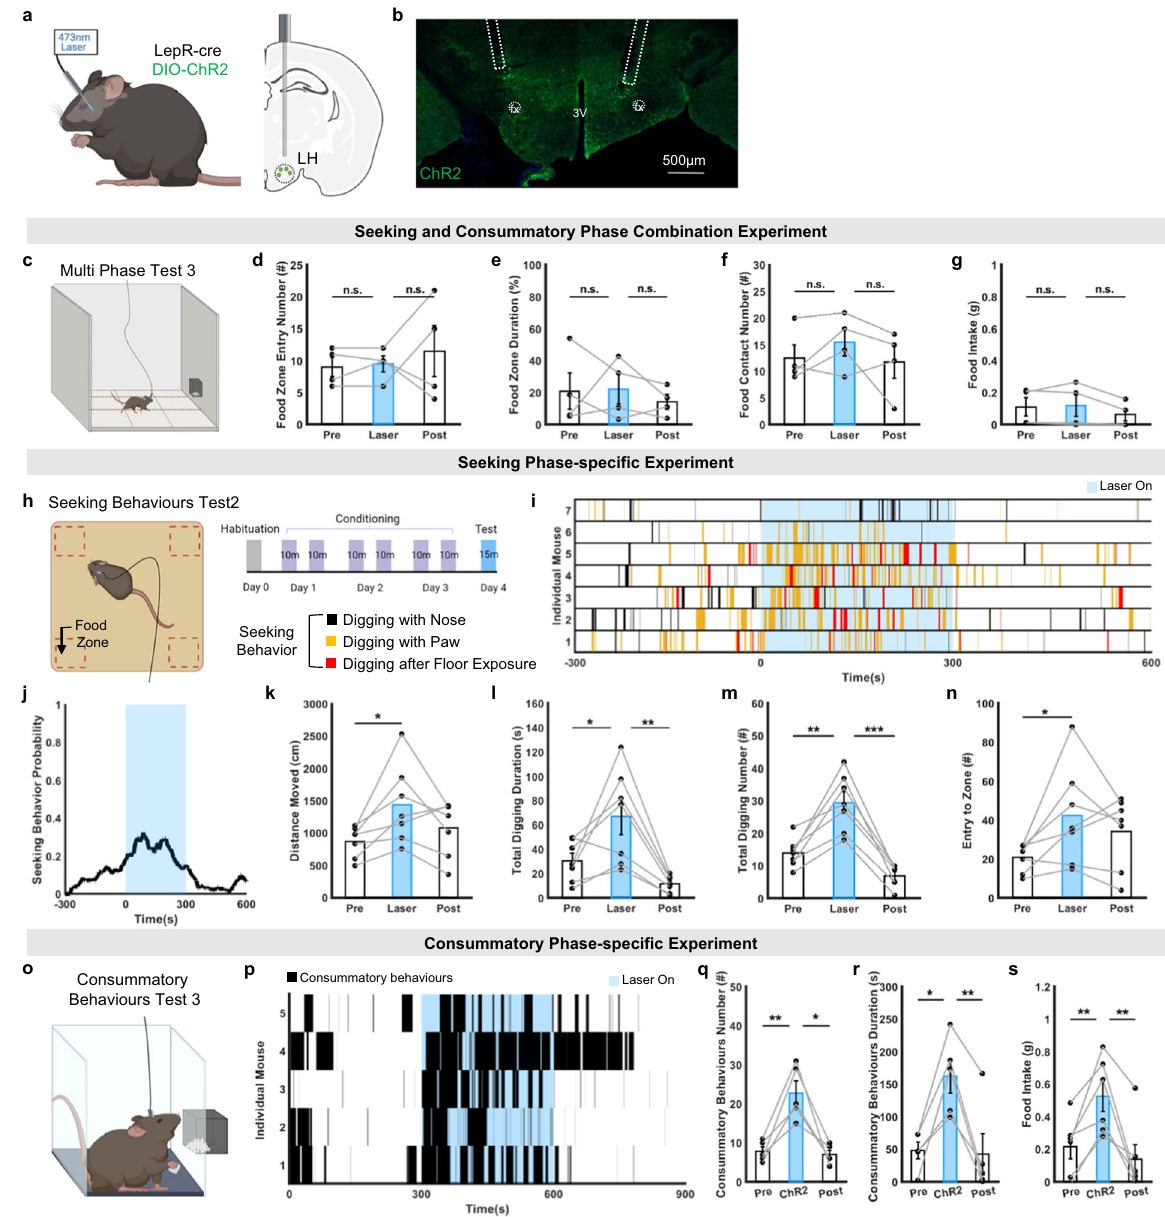
Fig. 4 | Activation of LH LepR neurons drives seeking or consummatory beha- viours. a , b Schematic of optogenetic activation and image of ChR2 expression in LH LepR neurons. The experiment was repeated at least 4 times independently with similar results. fx,fornix; 3V, the 3rd ventricle. c Schematic of the multi-phase test 3. d – g Number of food zone entries ( d ), duration in the food zone ( e ), number of food contacts ( f ) and food intakes ( g ) ( n =4 mice). Two-sided paired t-test; n.s., p >0.05. h , Schematic and schedule of the seeking behaviour test 2. i Raster plot during( h ). j Behaviouralprobabilityfrom( i ). k – n Quanti fi cationofdistancemoved ( k ), total digging duration ( l ), number of digging behaviours ( m ) and frequency of foodzoneentries( n )( n =7mice).Two-sidedpairedt-test;* p =0.02( k ,prevslaser),